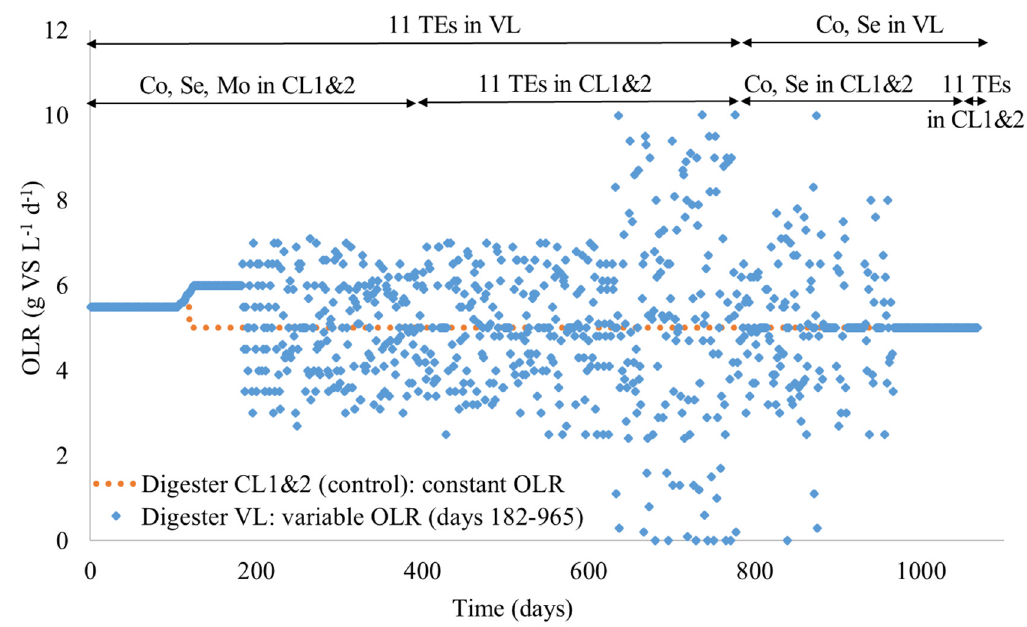
Figure 1. Operational scheme of digesters used in this study, including organic loading rate (OLR) change and trace elements (TE) supplementations (VL: digester with variable loading, CL: digester with constant loading).